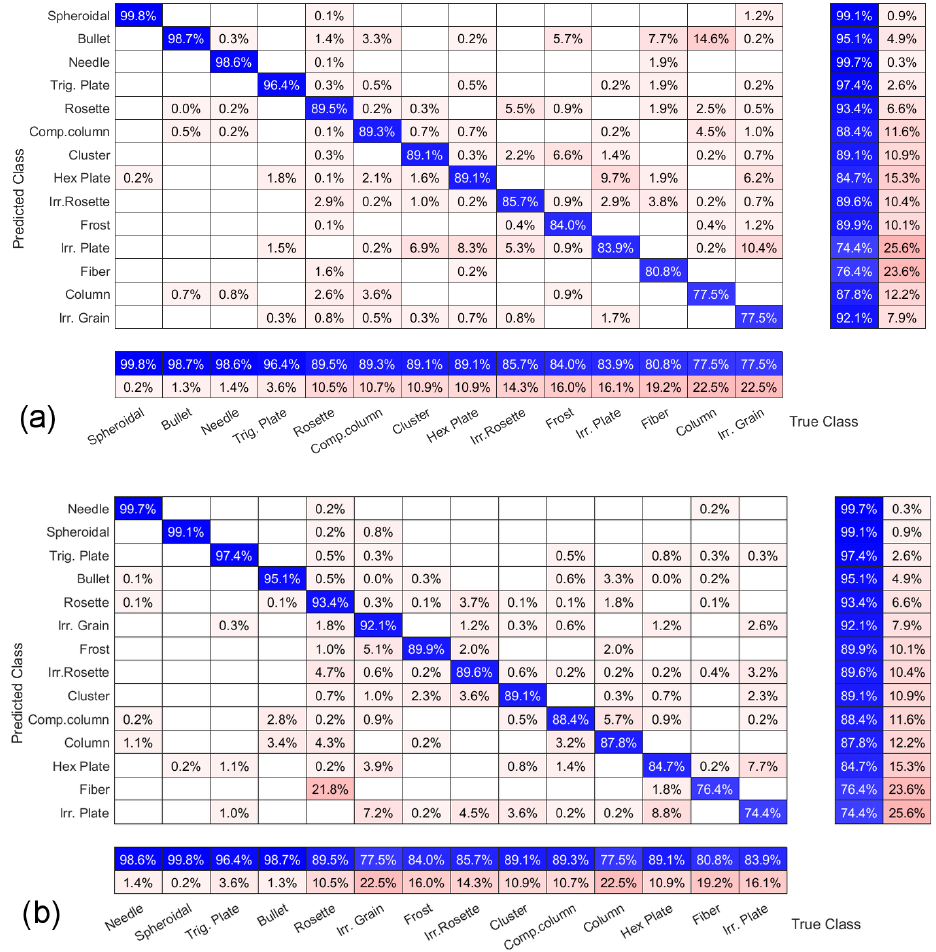
Figure 17. Confusion plot of the CNN: (a) column normalised, (b) row